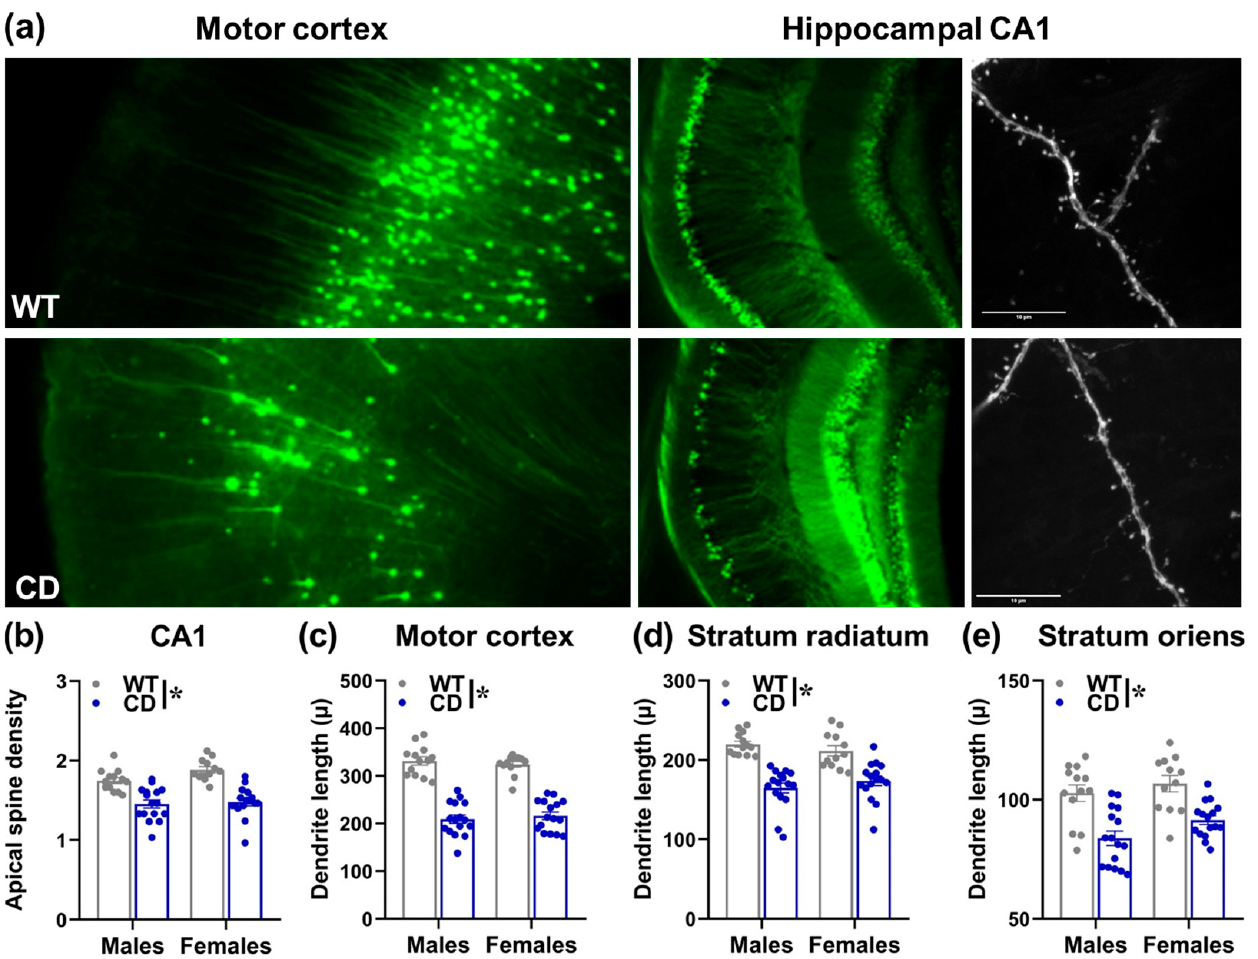
Figure 9. Brain abnormalities in juvenile CD mutant mice. Representative pictures of dendrites in motor cortex and CA1 areas (scale bar 10 µ ) of WT and CD mice ( a ). Dendritic spine density ( b ), dendritic length ( c – e ), were assessed in CD mice and their WT littermates at the juvenile age (i.e., 5– 7 weeks). A separate batch of behaviorally naïve animals was employed for this study. * = p < 0.05 refers to the main effect of genotype n = 29 males (13 WT, 16 CD) and 28 females (12 WT, 16 CD).